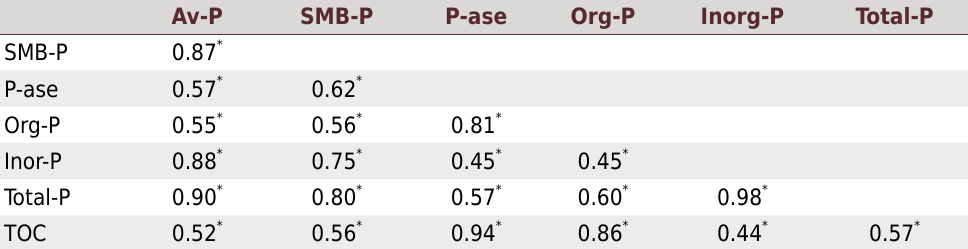
Table 5. Linear correlation ( r 2 ) coefficients between Av-P, SMB-P, P-ase, Org-P, Inorg-P, and Total-P in response to 19 successive PS applications over 8 years, in Santa Maria, Rio Grande do Sul,